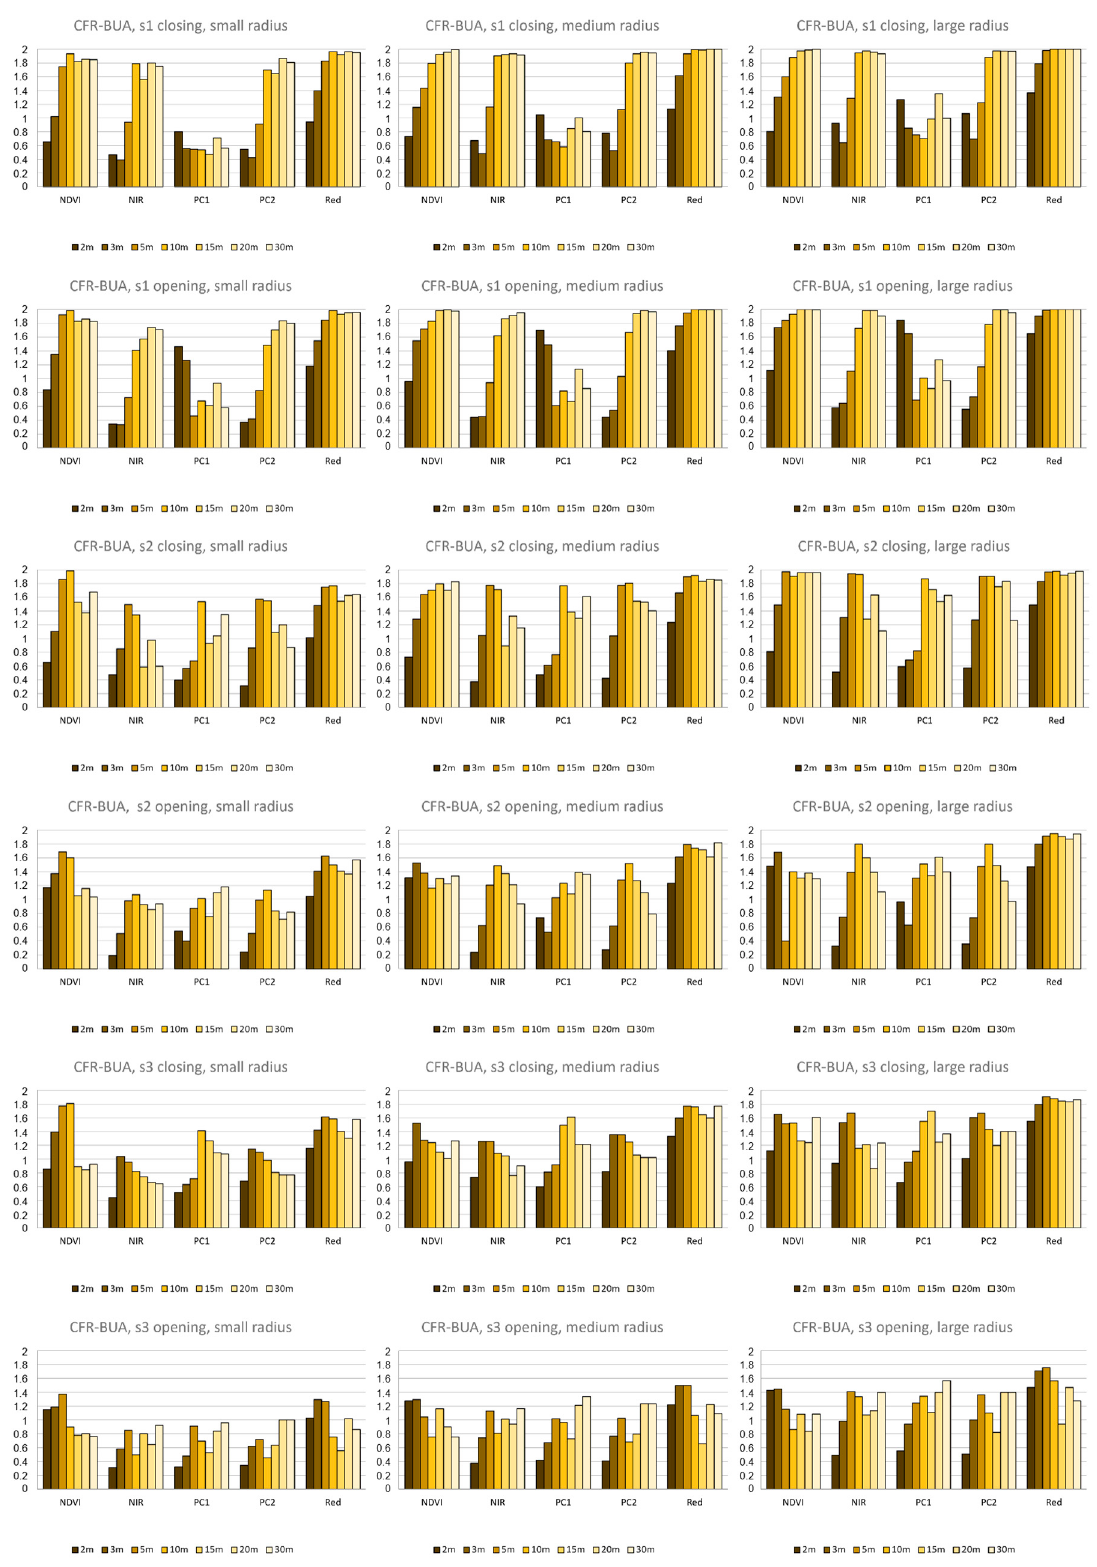
Figure 9. Averaged J–M distances for test fields for the coniferous forest/built-up area class pair (CFR/BUA).